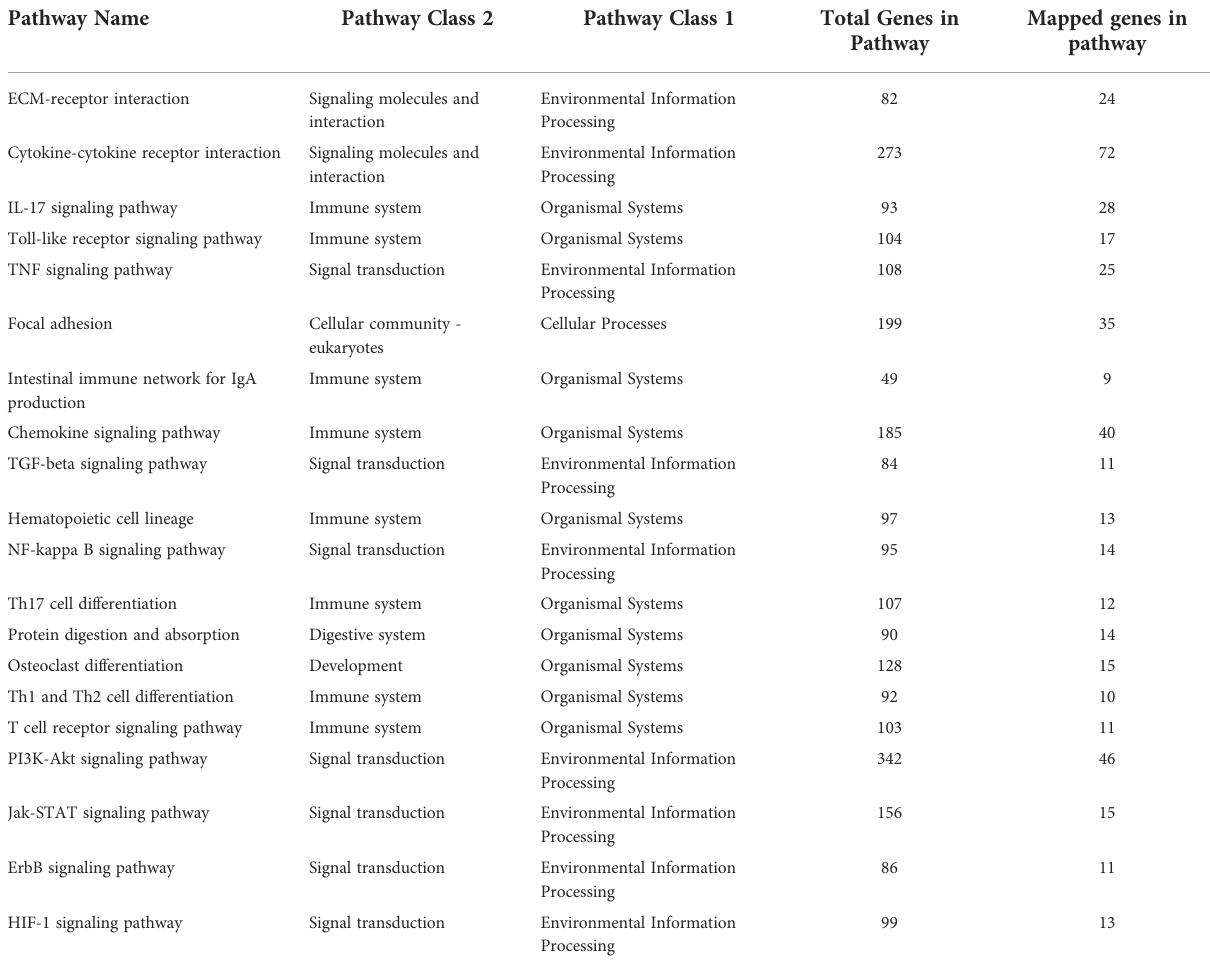
TABLE 2 Pathways signi fi cantly affected by the differentially expressed